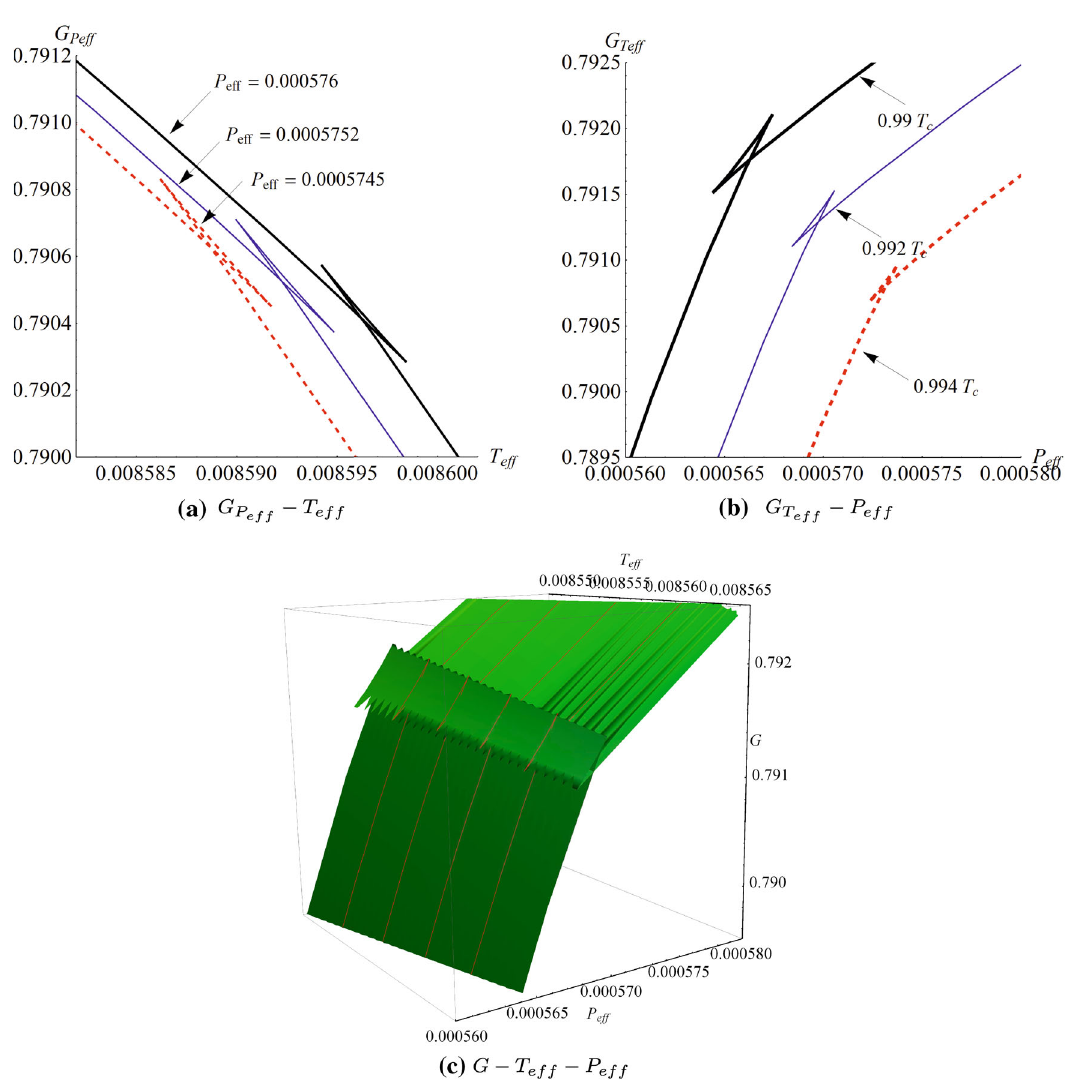
Fig. 7 The swallow tail behaviors of Gibbs free energy nearby the critical point in 2-dimension and